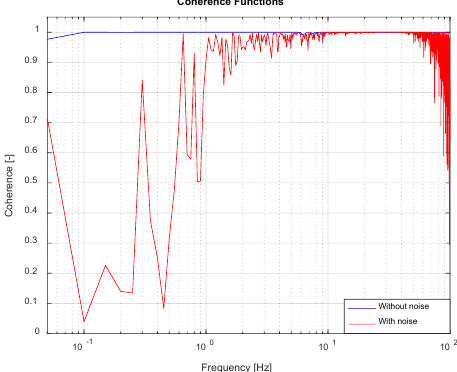
Figure 13. Coherence functions comparison.